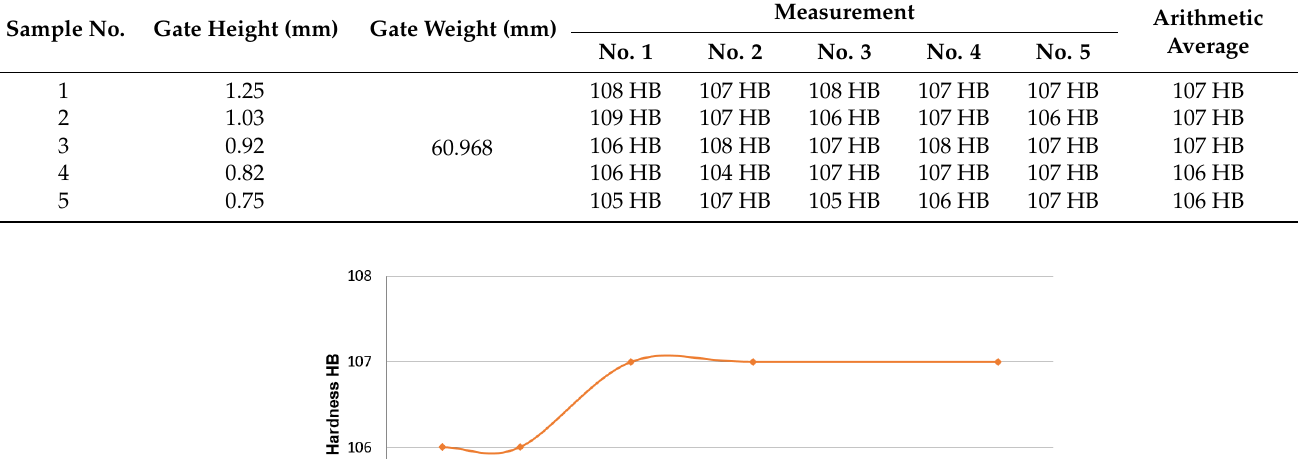
Table 9. Values of the surface hardness of the die-cast part “HB” in relation to change of the ingate height. Sample No.